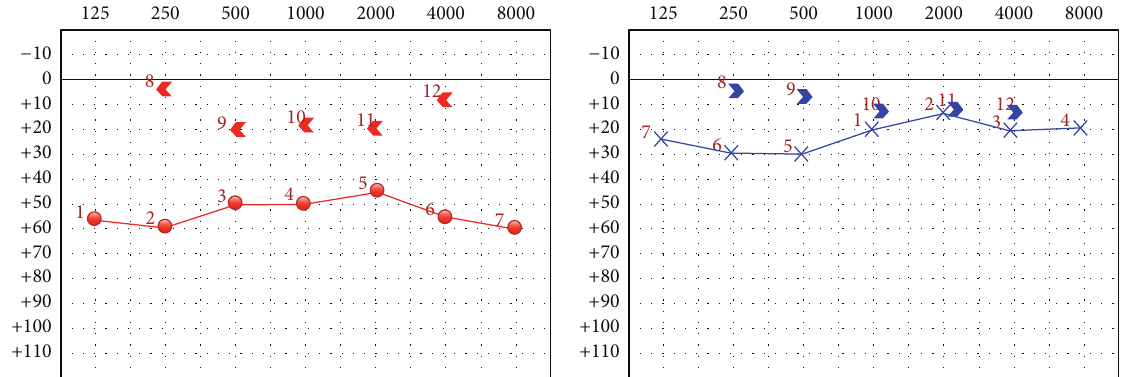
Figure 1: Right ear in red and left ear in